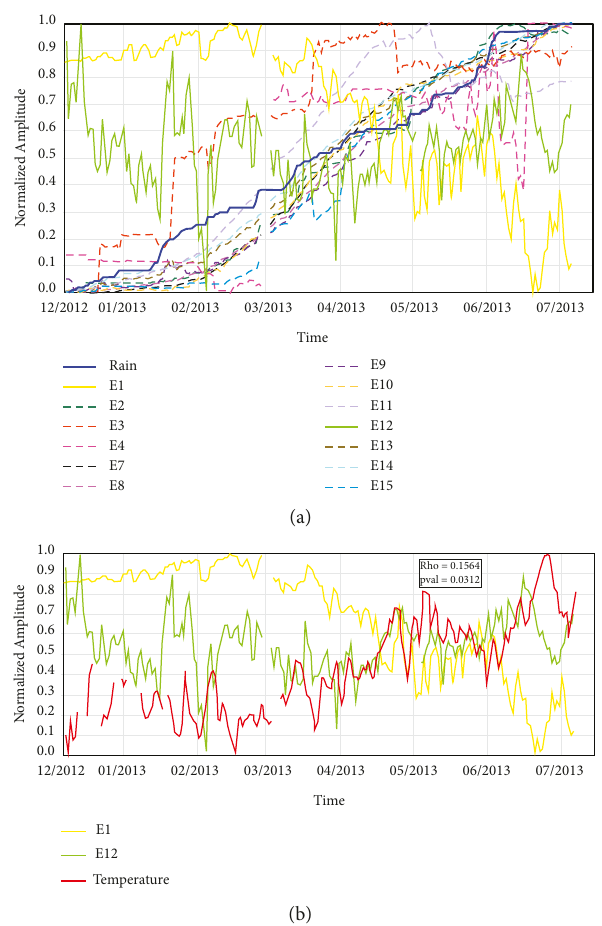
Figure 9: (a) The extensometerand rain trends and (b) two selected extensometer and temperature trends. The E2, E7, E8, E9, E10, E13, E14 trends showa clearcorrelationwith theprecipitation; the E3, E4, E11, E15 trends show a weaker correlation with the rain; the E1 trend shows an inverse correlation with the rain; the E12 trend does not show correlation either with rain or with temperature.